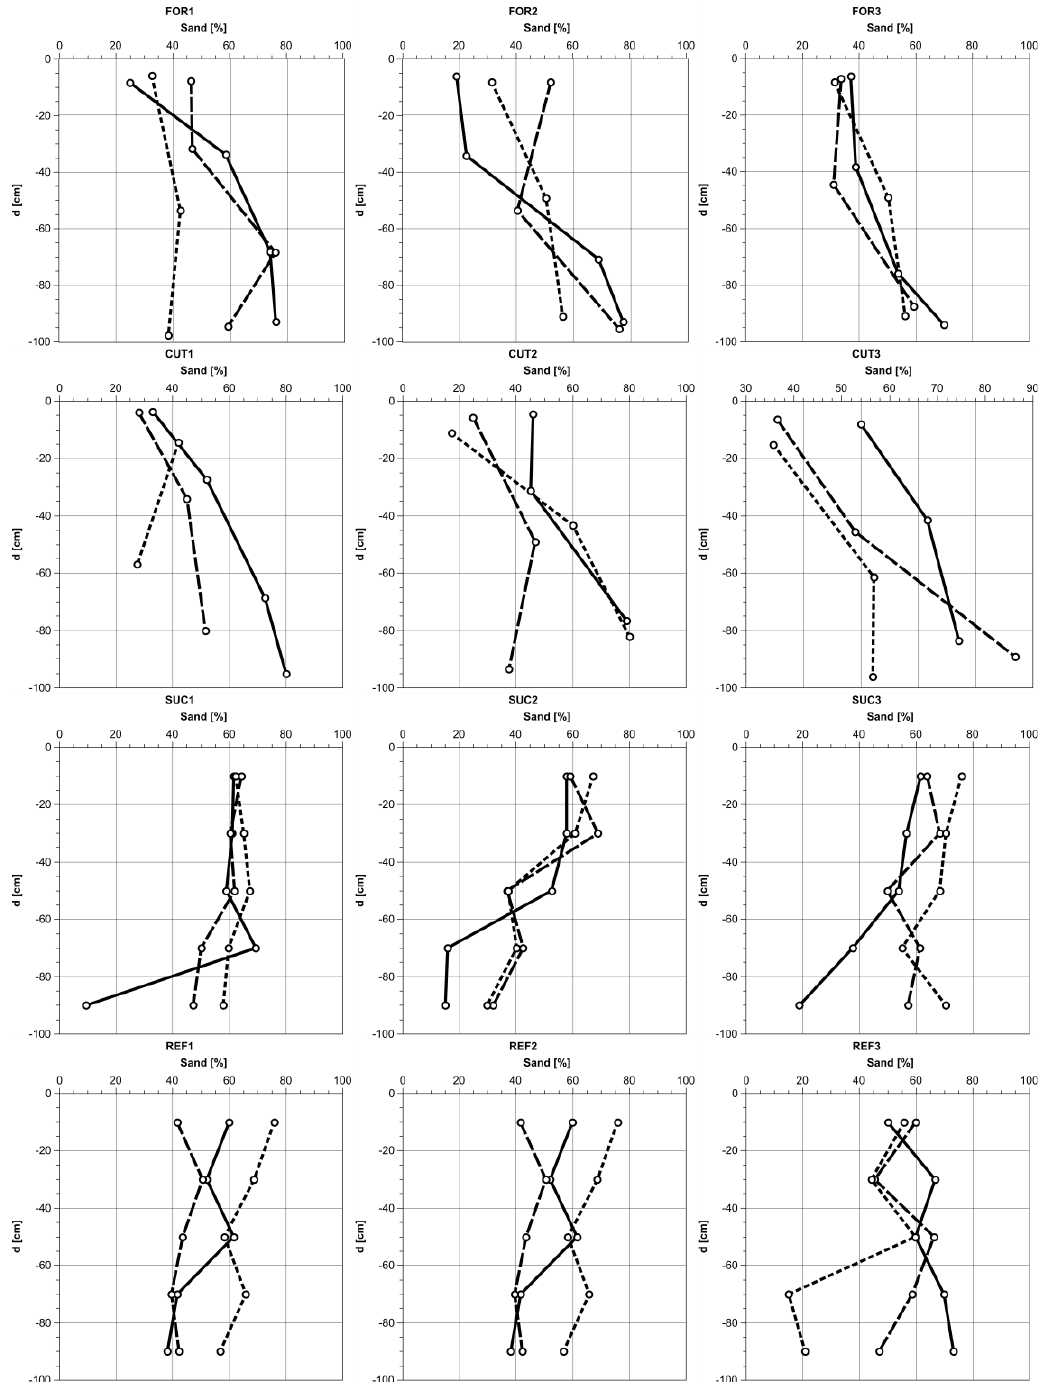
Figure 7. Depth-related sand content for every catena: (FOR)est, (CUT)-down, (SUC)cession, (REF)forested; solid line: upper slope, dashed line: middle slope, dotted line: lower slope.